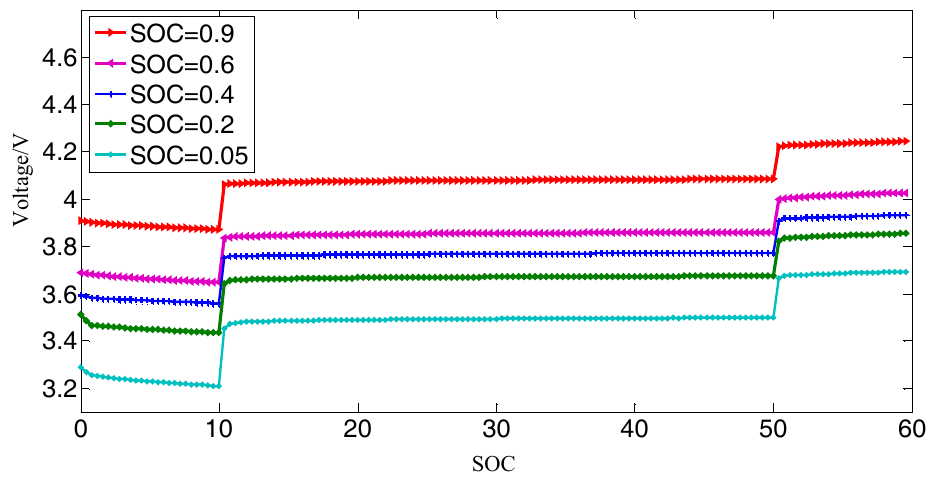
Figure 5. Voltage response curves by HPPC test at different SOC.